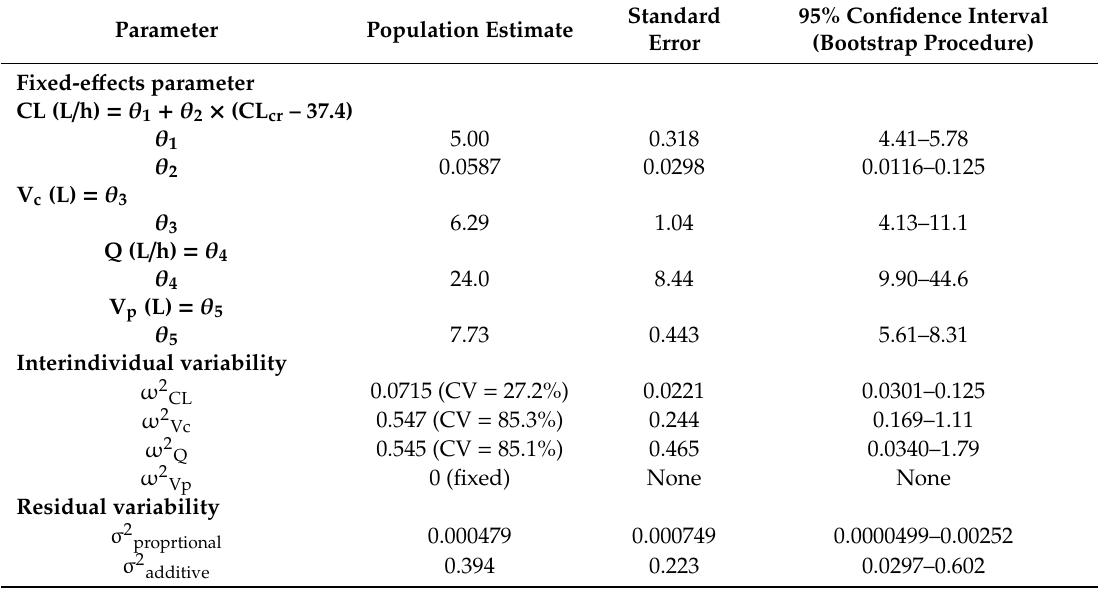
Table 3. Estimate of population PK parameters of tazobactam (TAZ) in the final model.